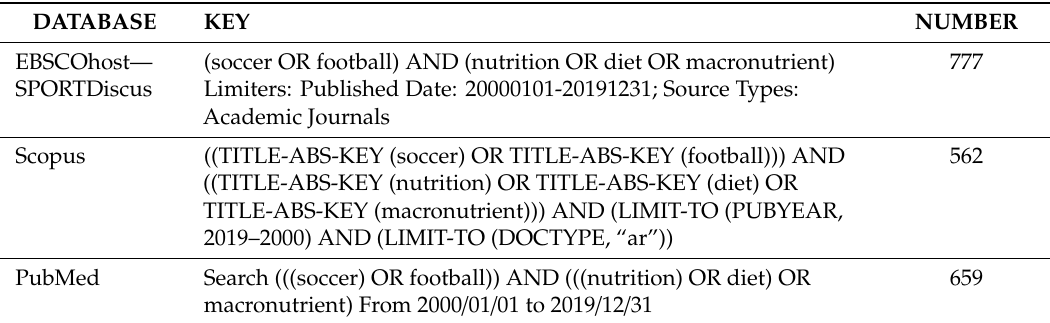
Table 1. Search string and results from electronic